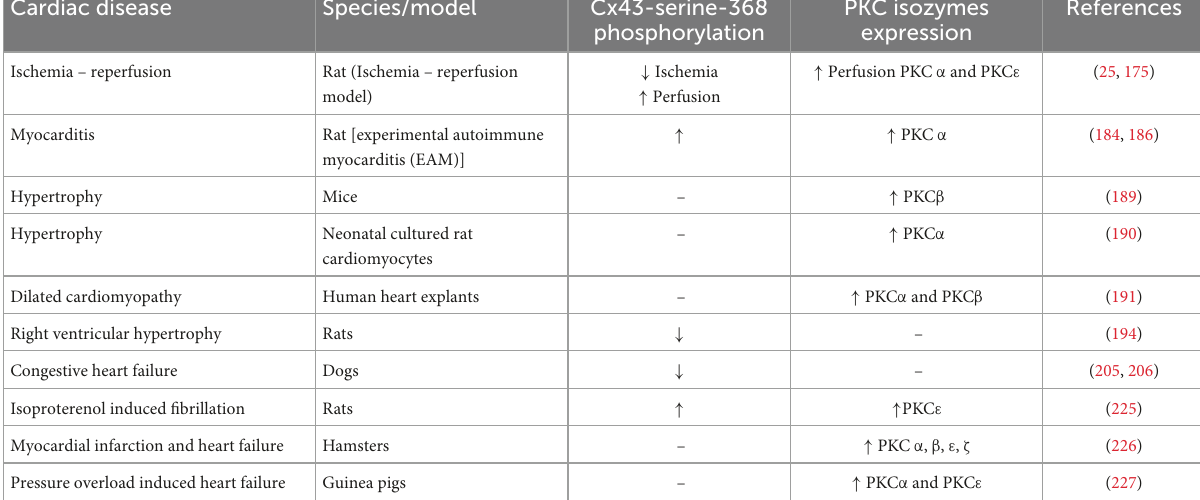
TABLE 2 Summary table of the phosphorylation of Cx43-Serine-368 and expression level of PKC isozymes in various cardiac disorders. Cardiac